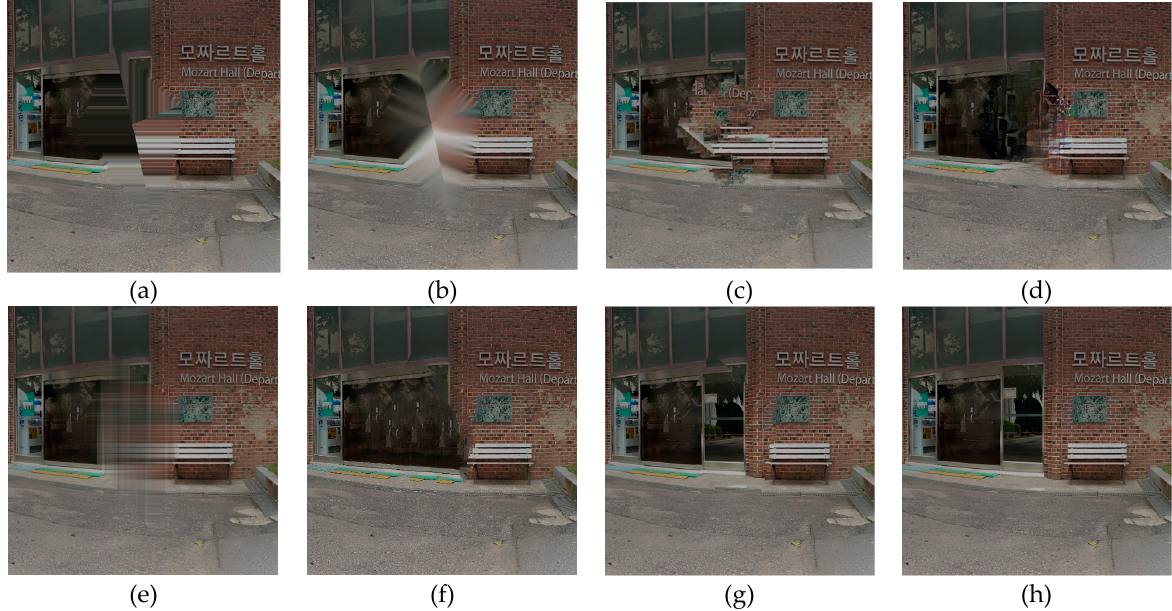
Figure 11. Concealed images resulting from various algorithms for test set Mozart Hall: ( a ) Result from Bertalmio [16]; ( b ) Result from Telea [17]; ( c ) Result from Criminisi [18]; ( d ) Result from Liu [19]; ( e ) Result from Gilisoft Stamp Remover [33]; ( f ) Result from Theinpaint [34]; ( g ) Result from simple copy; ( h ) Result from proposed method.